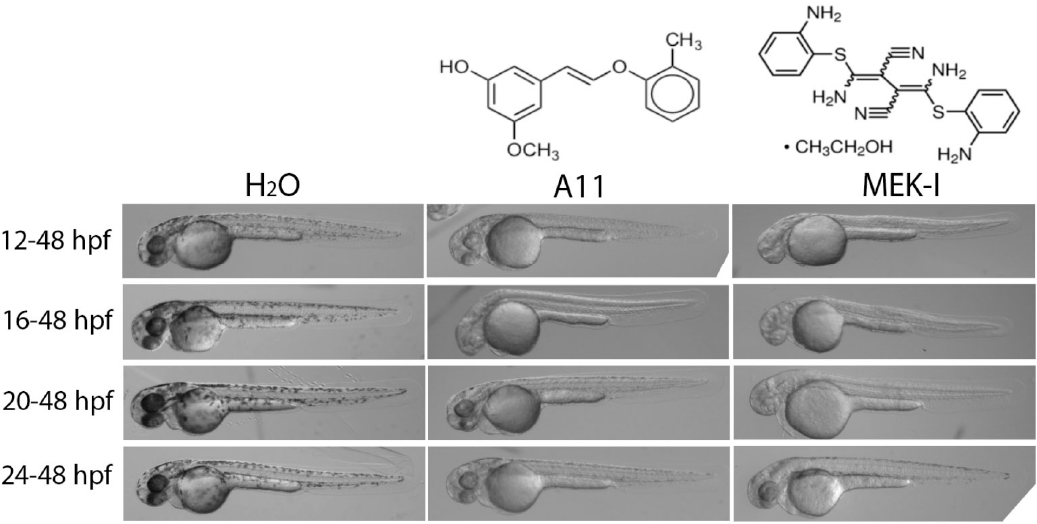
Figure 1. A11 and MEK-I cause strong pigment inhibition in early zebrafish embryos. Zebrafish embryos were treated with A11 or MEK-I starting from 12, 16, 20, or 24 hpf (hours post fertilization) to 48 hpf. Embryos in H 2 O showed normal level of pigment. A11 and MEK-I both caused strong inhibition in pigment formation. However, while A11 showed consistent potency in the different stages of treatment, the potency of MEK-I appeared weaker in the 24–48 hpf embryo.